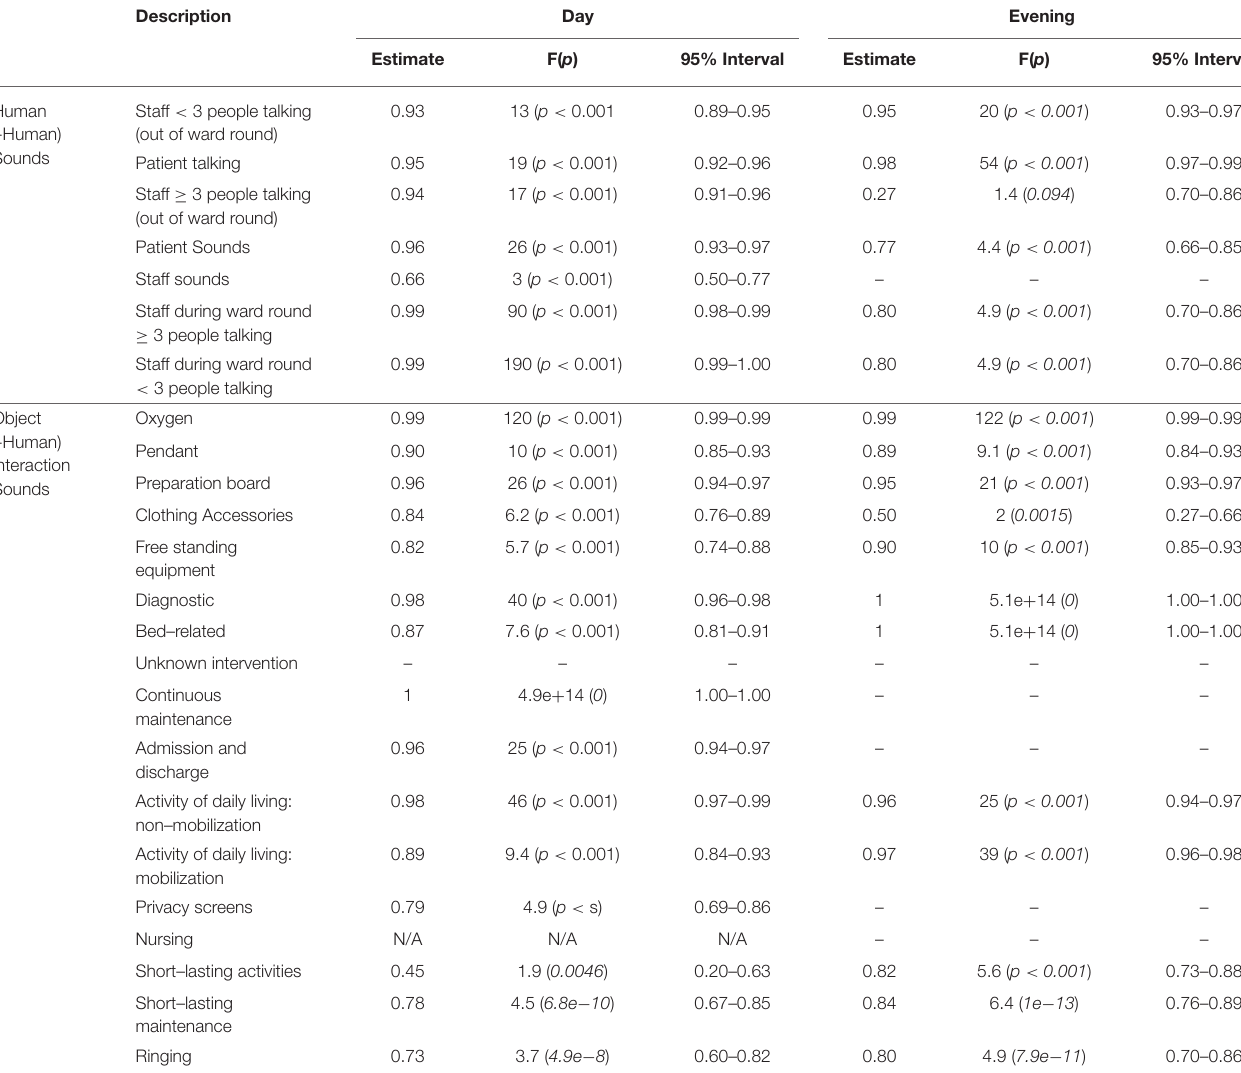
TABLE 1 | Full ICC estimates obtained using a two-way mixed-effects model during the day and evening observation periods.